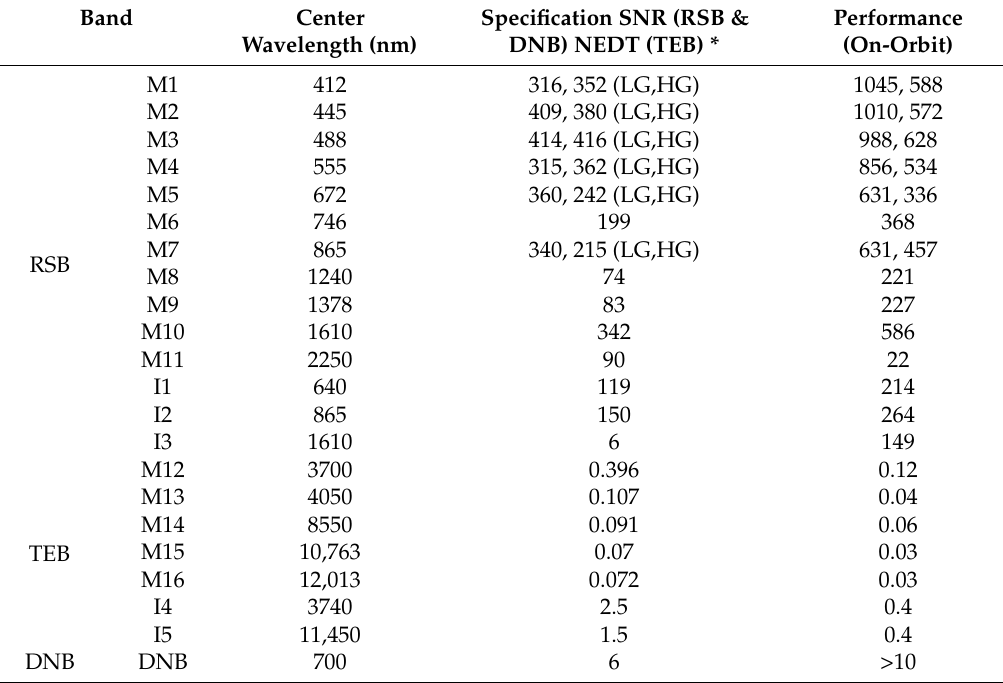
Table 1. S-NPP VIIRS SDR performance meeting the